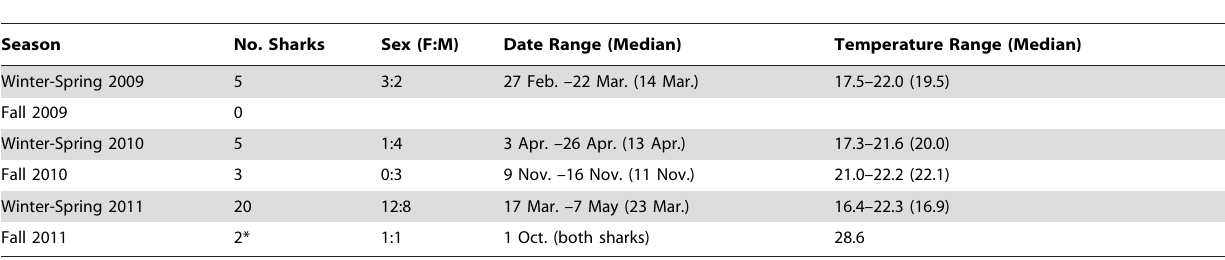
Table 4. Date and water temperature ( u C) associated with lemon sharks passing by Ponce de Leon Inlet during annual migrations.